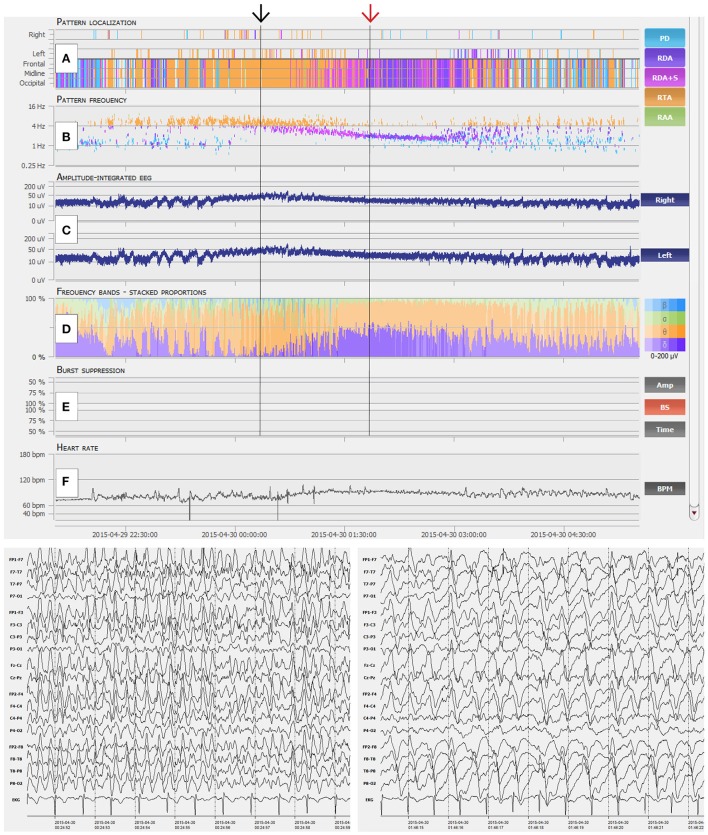
Interpretation of NeuroTrend. (A) Recurrent seizures are detected as generalized rhythmic theta activity (RTA, orange plots) between 22:30 and 00:00. Then ongoing seizure activity is displayed by ongoing detection of RTA until 01:30. Around 01:00 detection of generalized rhythmic delta activity (RDA, pink and violet plots) overlap with RTA and further increases until 03:00. (B) Related pattern frequency detection reveal clear cut seizures above 3 c/s between 22:30 and 01:30 (black arrow). Overlapping RDA show a steady decrease from 3.5 to 2 c/s (red arrow). (C) Amplitude integrated EEG shows increment and decrement over both hemispheres at the beginning of each seizure from 22:30 to 23:30. Then a steady increase over both hemispheres can be seen during ongoing seizure activity from 00:00 until 01:00. (D) Frequency bands show a dominance of theta activity during seizure activity and the overlap of theta and delta activity around 01:30. (E) No burst suppression was detected. (F) Heart rate does not really show a concordance to seizure activity. In synopsis, this example represent typical spatiotemporal evolution of electrographic seizure activity, which can be easily detected with the graphical user interface of Neurotrend.